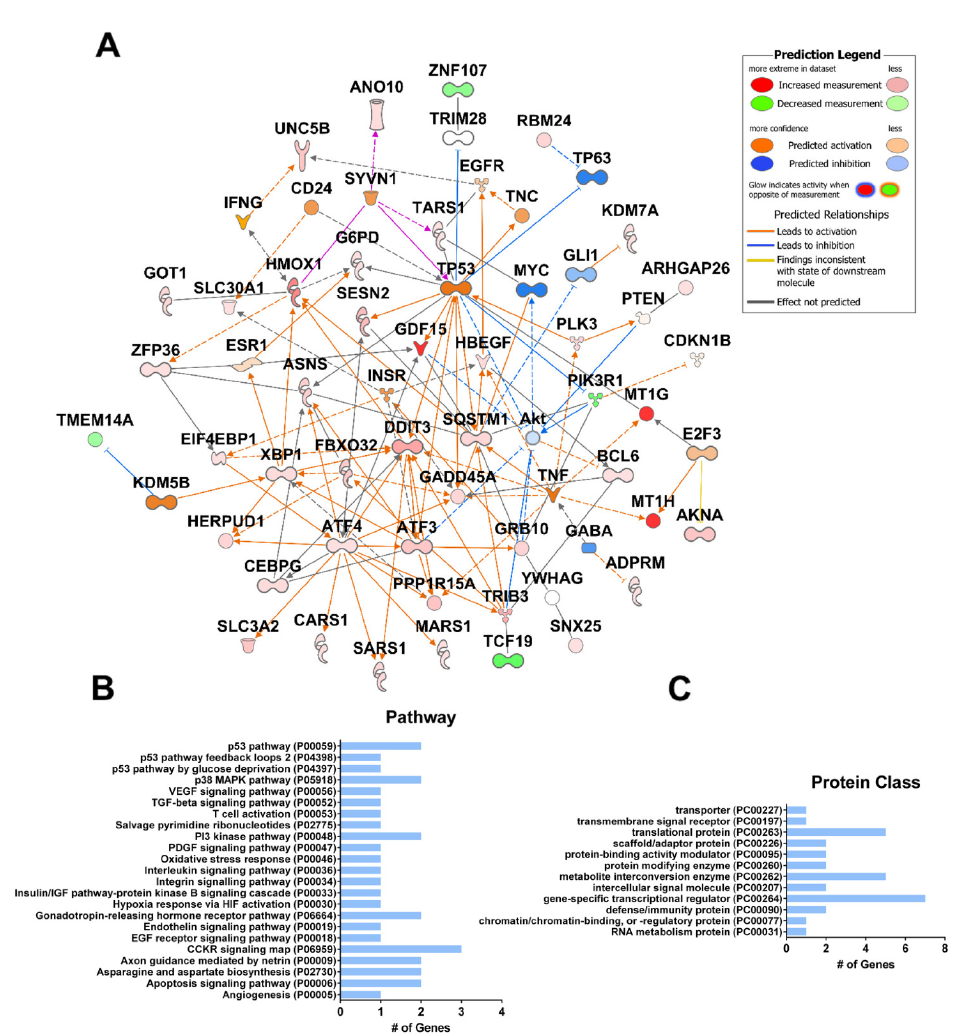
Figure 4. Common gene expression changes in CBD-treated SK-N-BE (2) neuroblastoma cells, hepatocellular carcinoma cells, and primary glioma stem cells. ( A ) Gene expression data were obtained from the NCBI GEO Database Series GSE151512 for SK-N-BE(2) cells, Series GSE179661 for hepatocellular carcinoma (HepG2 and MHCC97H), and Series GSE57978 for glioma stem cells. SK-N-BE (2) cells were treated with 20 µM CBD or vehicle (ethanol) for 24 h (n = 4). Three primary glioma stem cell lines were cultured as neurospheres and treated with 2 µM CBD or vehicle (ethanol) for 48 h (n = 3). Hepatocellular carcinoma cells were treated with 40 µM CBD for 24 h (n = 2). Significantly differentially expressed genes in each dataset were compared ( p ≤ 0.05). Ingenuity Pathway Analysis (IPA Qiagen) was used to create a network of known interactions between the differentially expressed genes common to both studies. The average fold change of common differentially expressed genes is shown. ( B ) Functional gene ontology classification of genes shown in ( A ) according to their gene ontology “Pathway” or ( C ) “Protein class” terms (pantherdb.org). # = number.